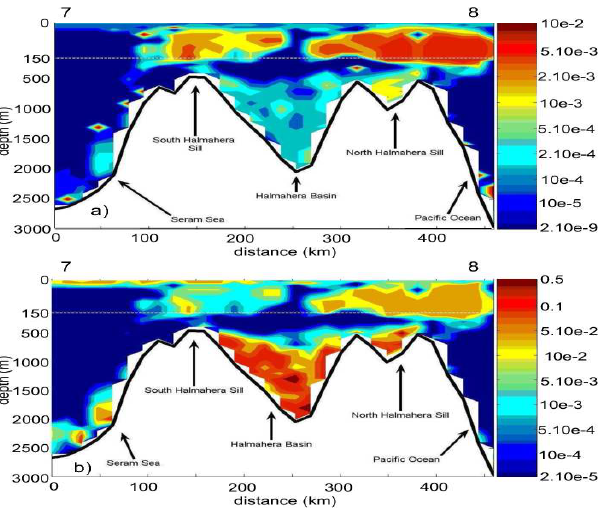
Fig. 5. Sections of (a) q 2 (m 2 s − 2 ) and (b) K M (m 2 s − 1 ) across the Halmahera Sea. Locations of points 7 and 8 at the top of the figures are given in Fig. 1.